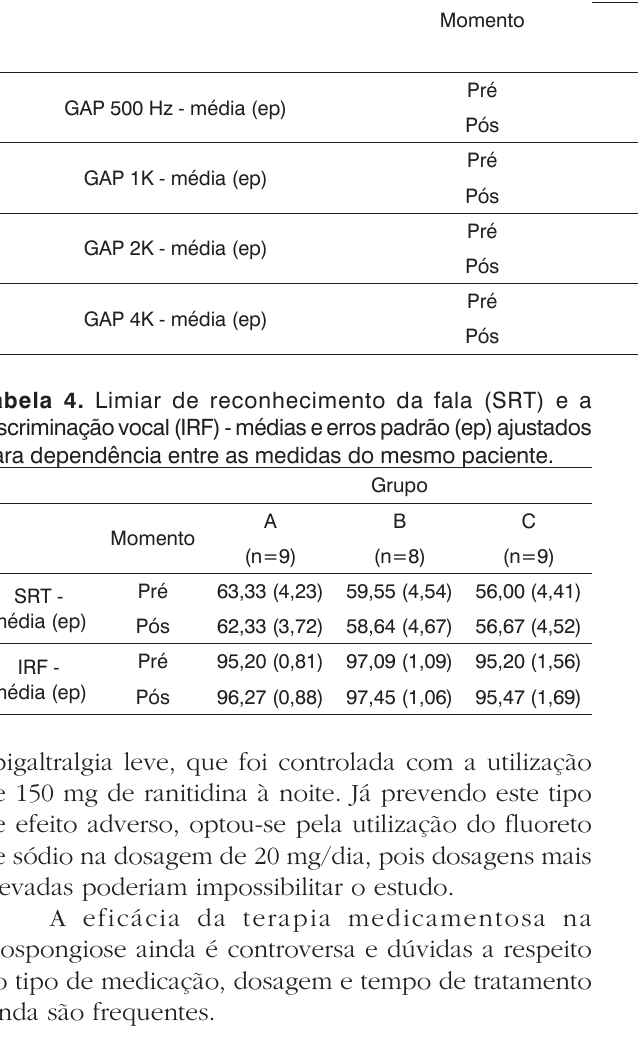
B razilian J ournal of o torhinolaryngology 78 (2) M arço /a Bril 2012 http://www.bjorl.org.br / e-mail: revista@aborlccf.org.br